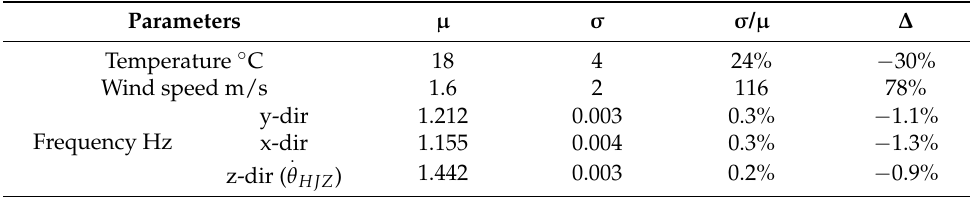
Table 1. Characteristics of the variations of the weather parameters and modal parameters ( ∆ corre- sponds to the variations during the local storm). Parameters µ σ σ / µ